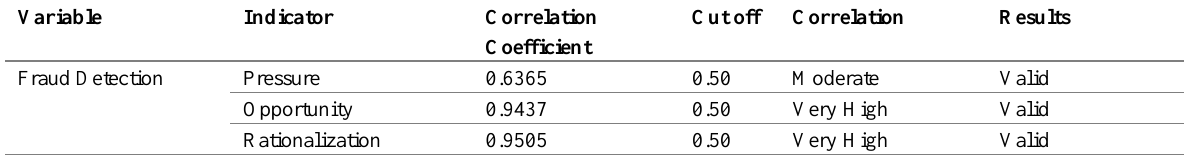
Table 3: Fraud Detection Variable Validity Test